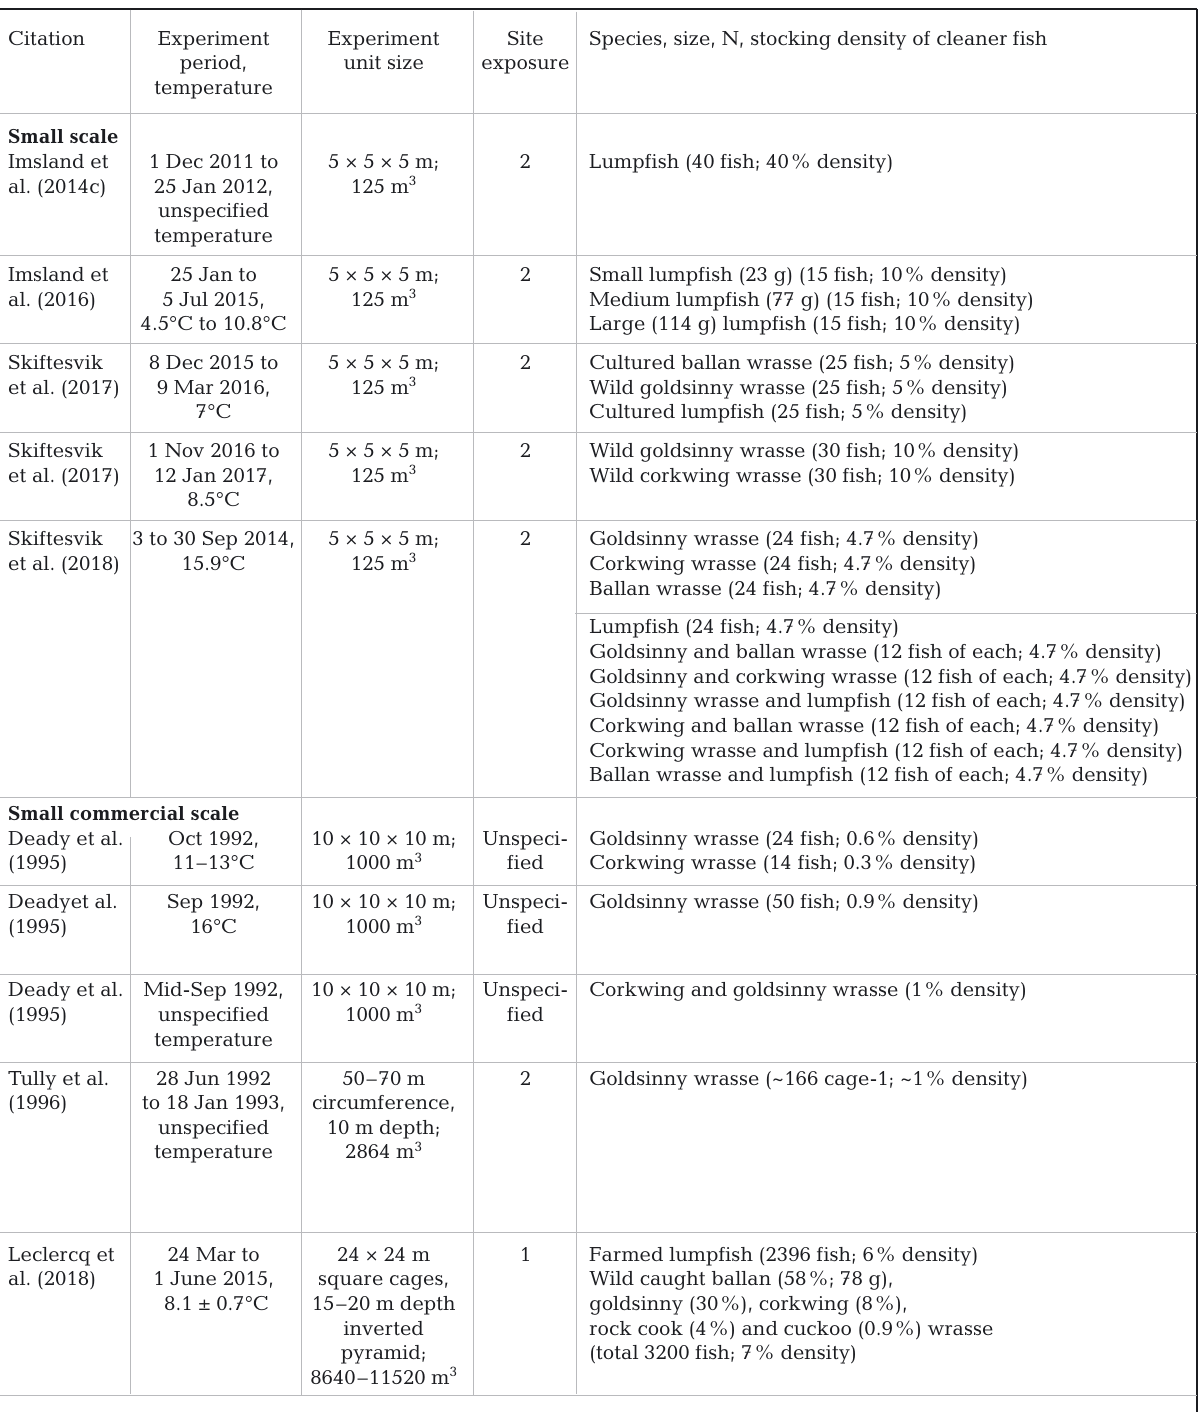
Table 1. A summary of the current literature (peer-reviewed journal articles and scientific reports) on experiments recording cleaner fish encounters with salmon in small scale (100−250 m 3 ) and small commercial scale (1000−15000 m 3 ) sea cages. Data include: experiment period and temperature, experiment unit size, degree of site exposure (where 1 = inner Loch or fjord, 2 = sheltered by at least one body of land, and 3 = exposed coastal site),